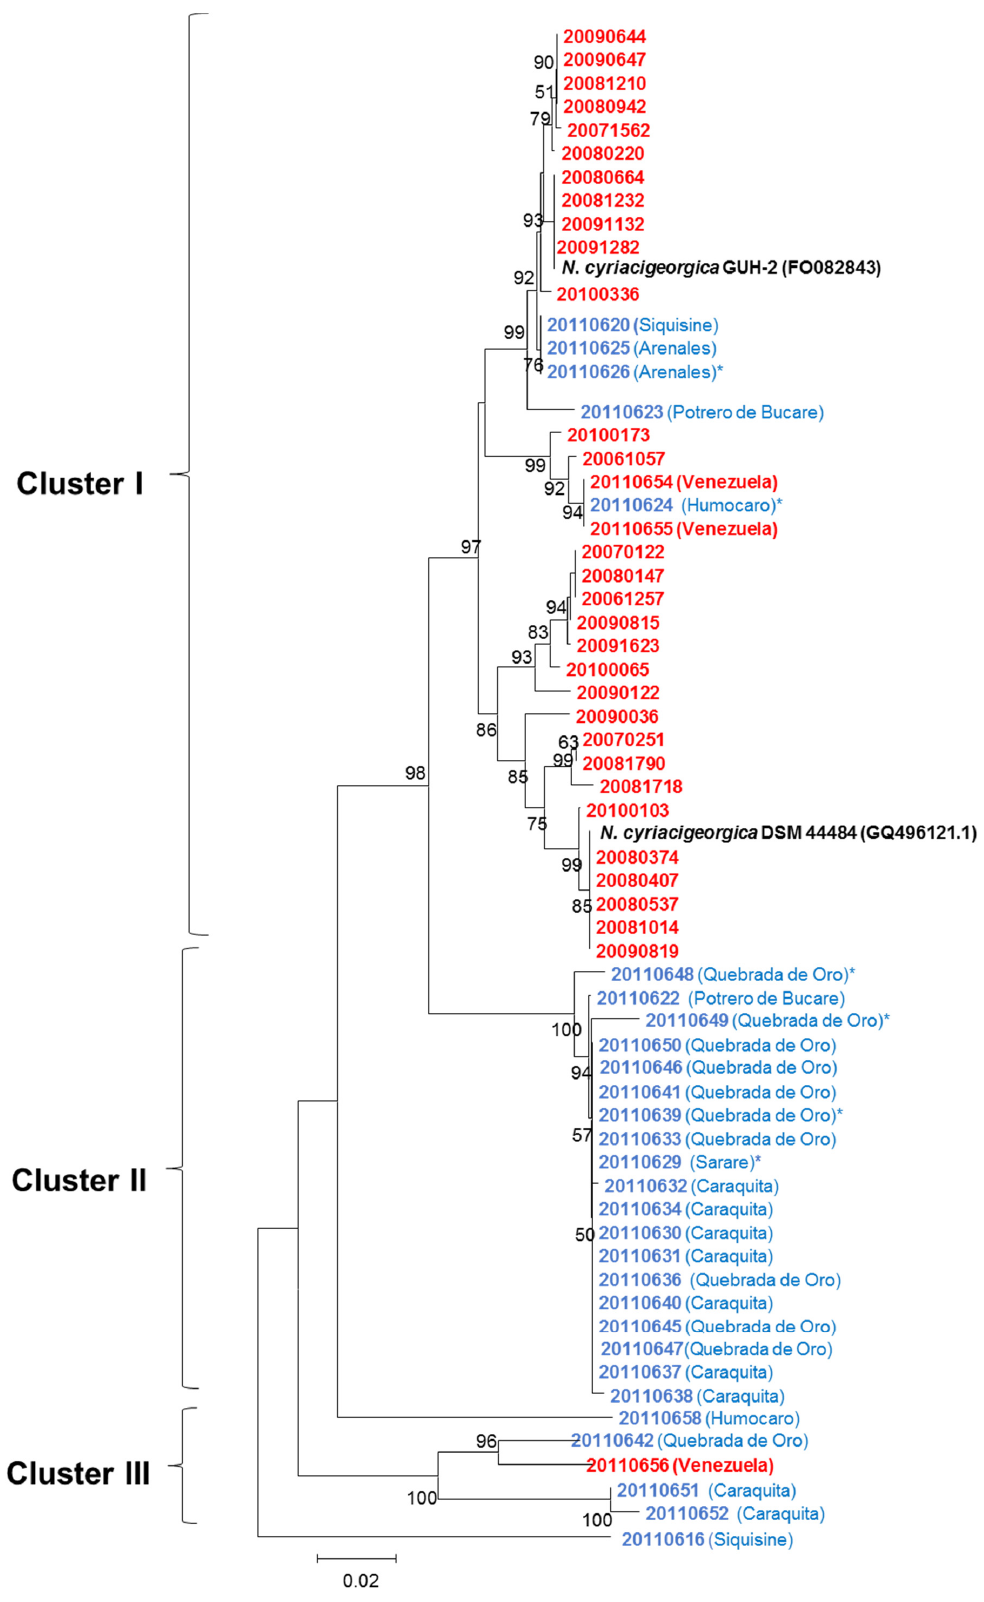
Figure 3. Phylogenetic relationships of the 29 Venezuelan N. cyriacigeorgica soil strains (in blue), three Venezuelan and 30 Spanish N. cyriacigeorgica clinical strains (in red), as revealed by their gyrB genes. The reliability of the NJ topologies was assessed by the bootstrap method (1000 replications). The asterisk indicates the strains selected for